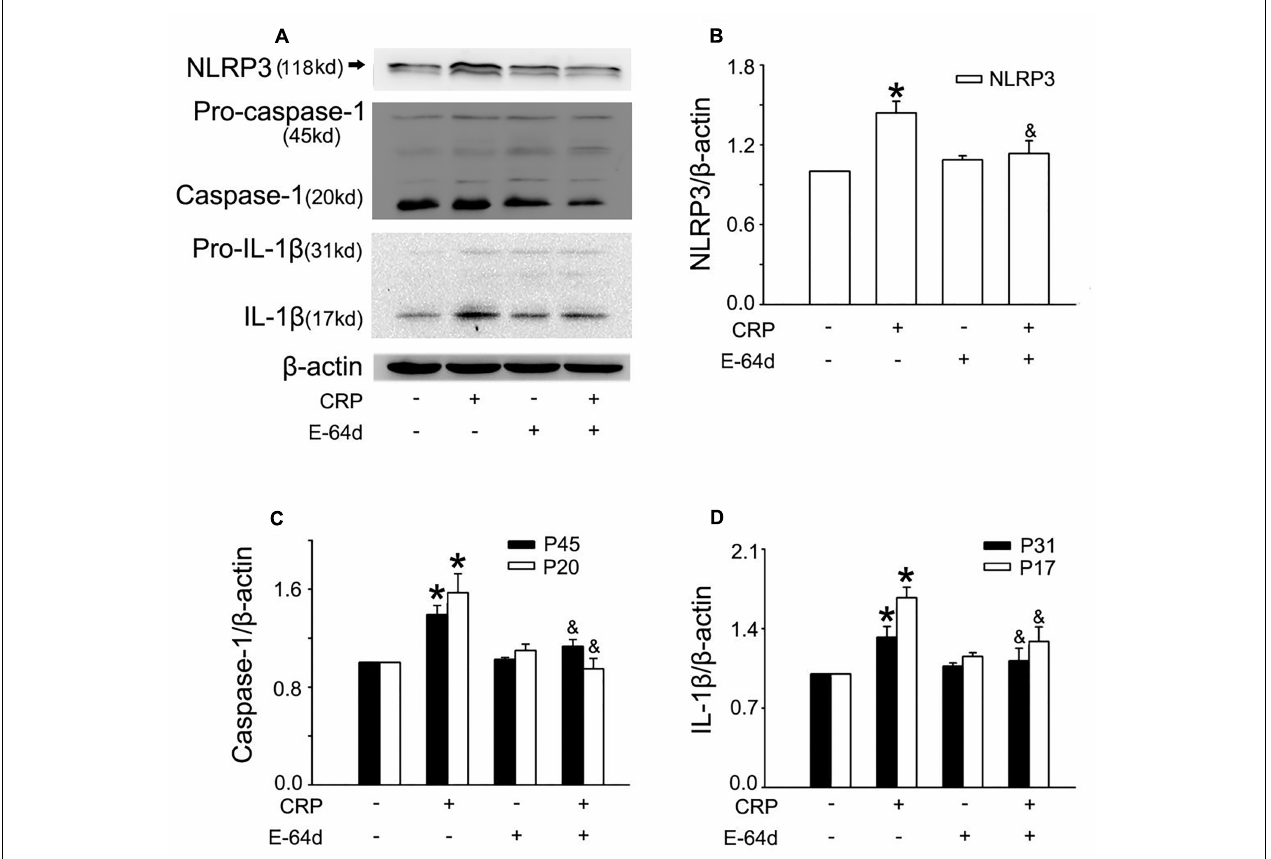
FIGURE 5 | Cysteine proteases are associated with CRP-induced NLRP3 inflammasome activation. HUVECs were incubated with 50 µ mol/L E-64d for 1 h, and then were treated in the absence or presence of 20 µ g/mL CRP for 24 h. (A) Representative Western blots showing the expression of NLRP3, pro-caspase-1, caspase-1, pro-IL-1 β , and IL-1 β . (B–D) Summary bar graphs showing the expression of proteins. ∗ P < 0.05 vs. Ctr; & P < 0.05 vs. CRP; n = 4.